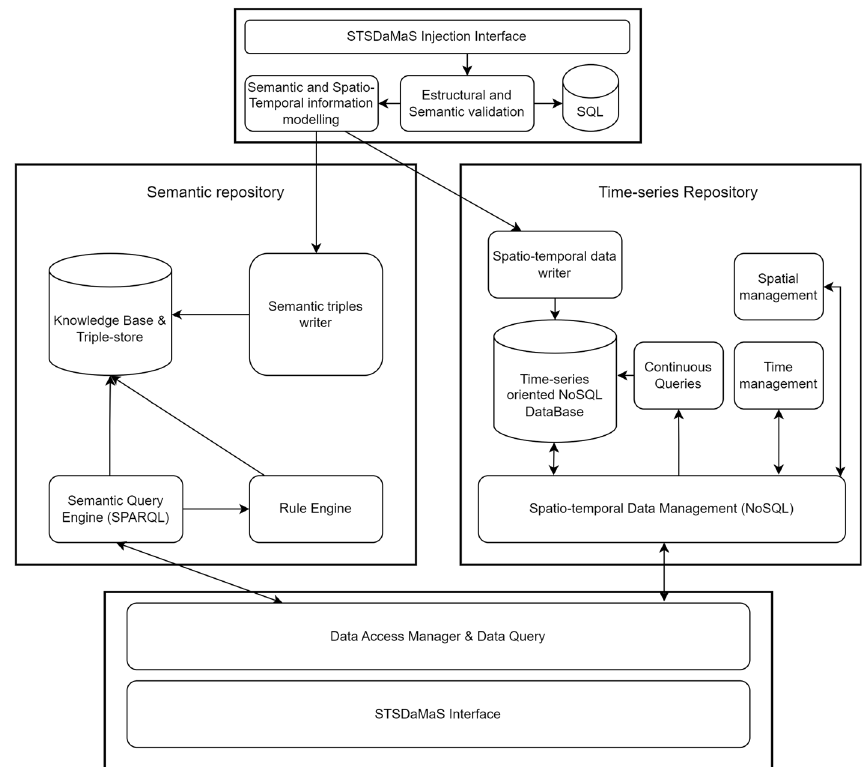
Fig. 2 Spatio‑temporal semantic data management system